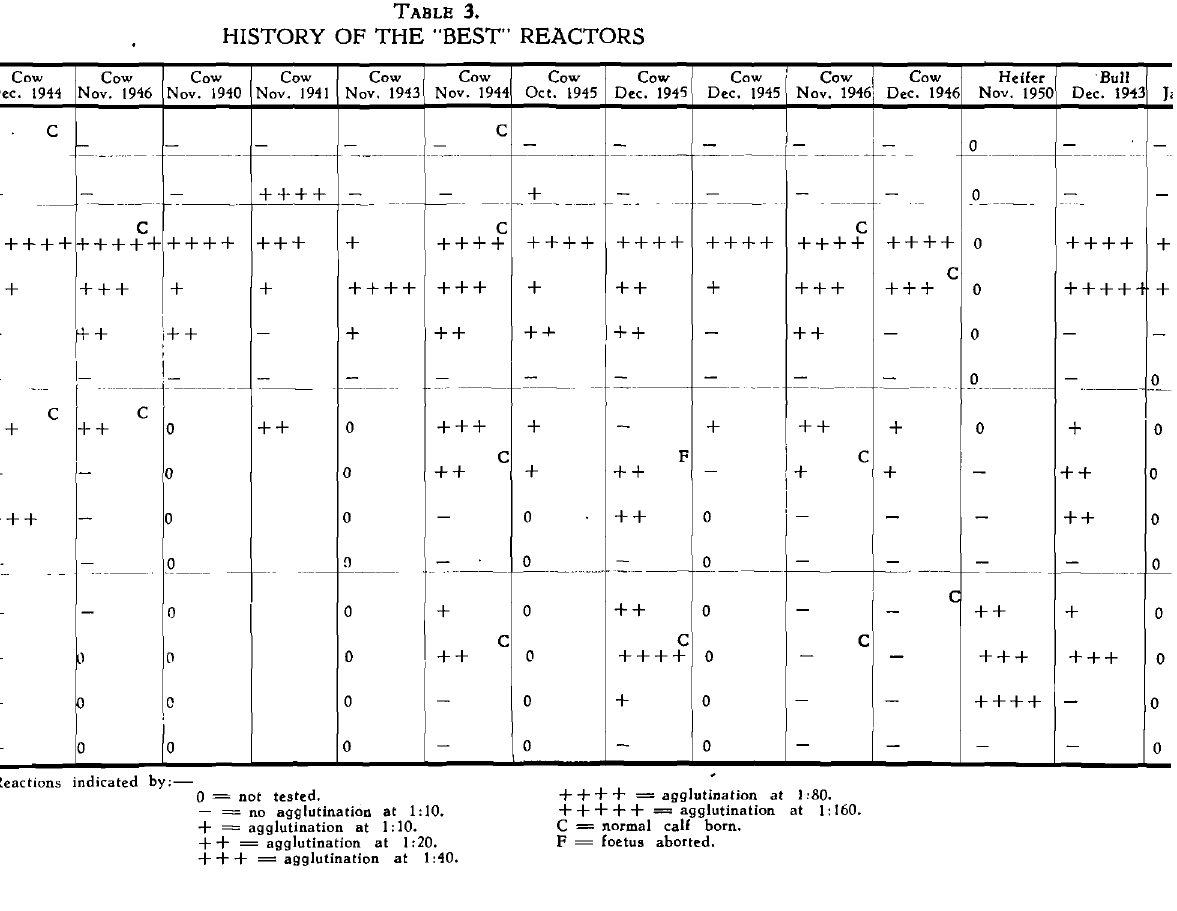
TABLE 3. HISTORY OF THE "BEST"